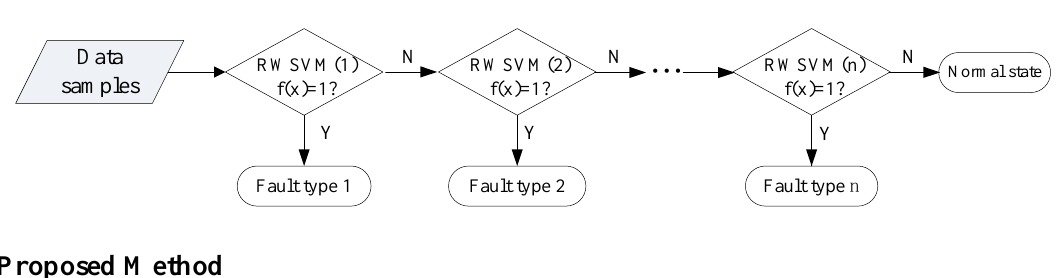
Figure 5. ‘One-versus-rest’ multi-class RWSVM.